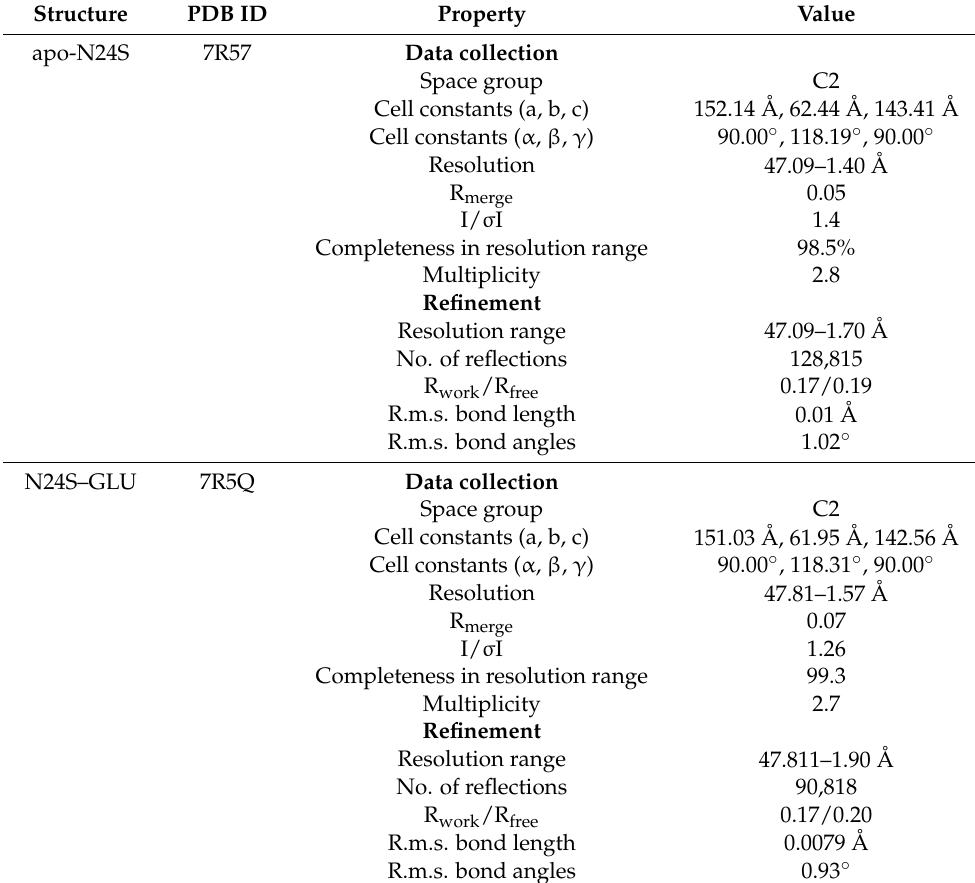
Table 1. Data collection and refinement